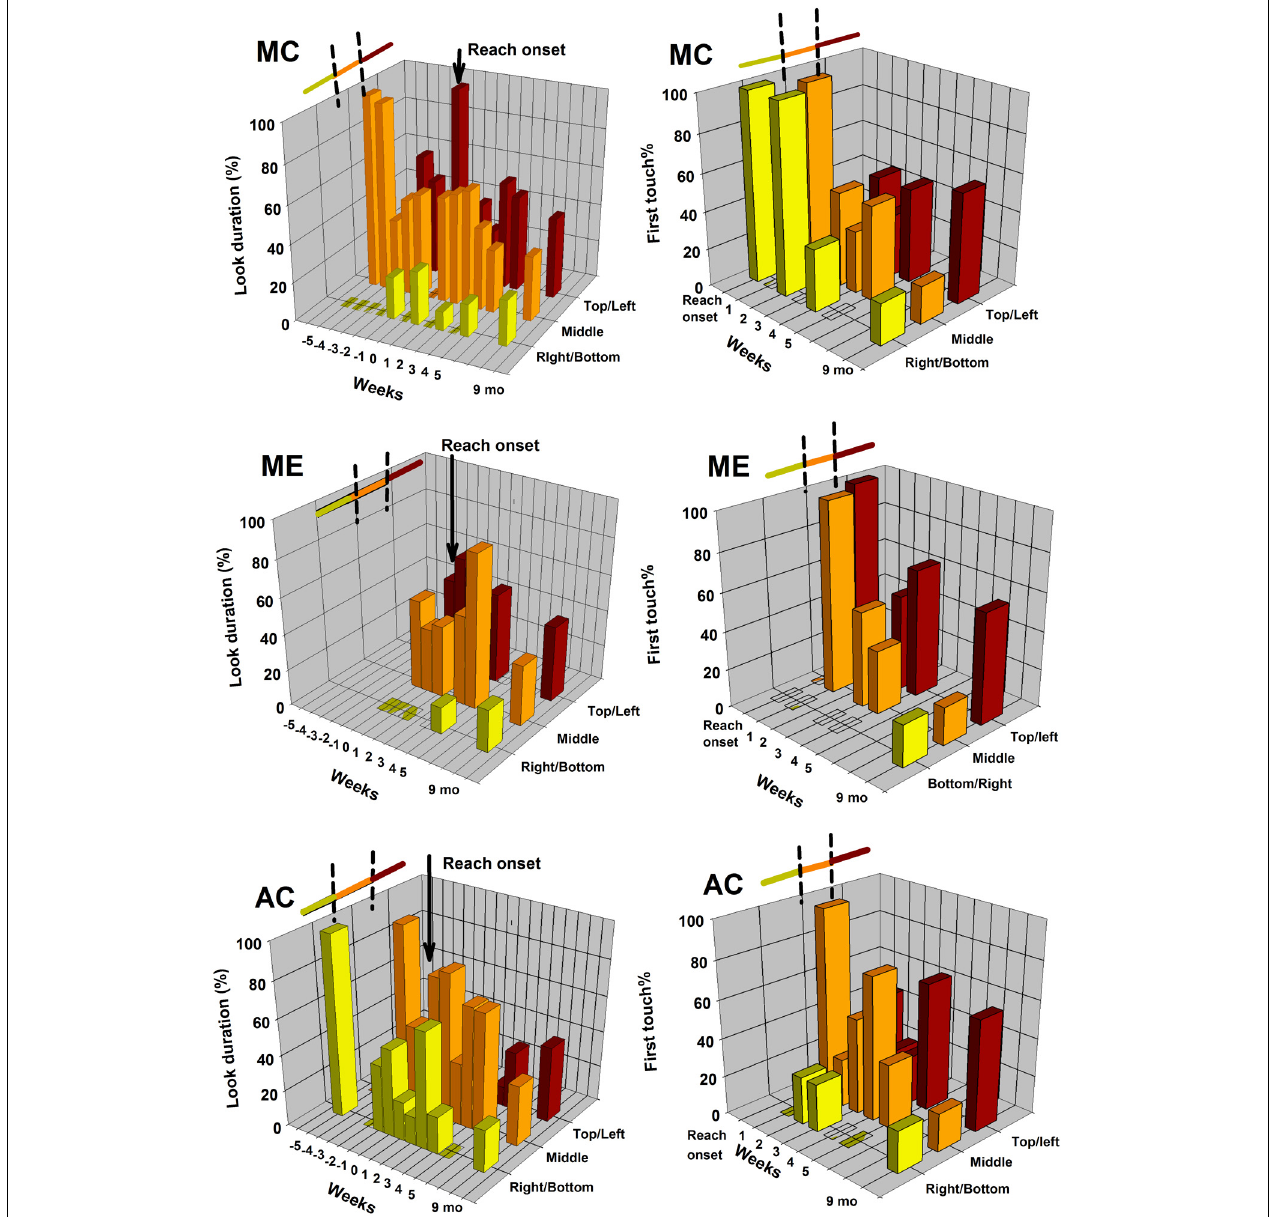
FIGURE 4 | Plainrodobject. The3Dbargraphsaredisplayingthedistributions of looking patterns on the object (graphs on the left) and distribution of first touched object area (graphs on the right) for each of the three longitudinal